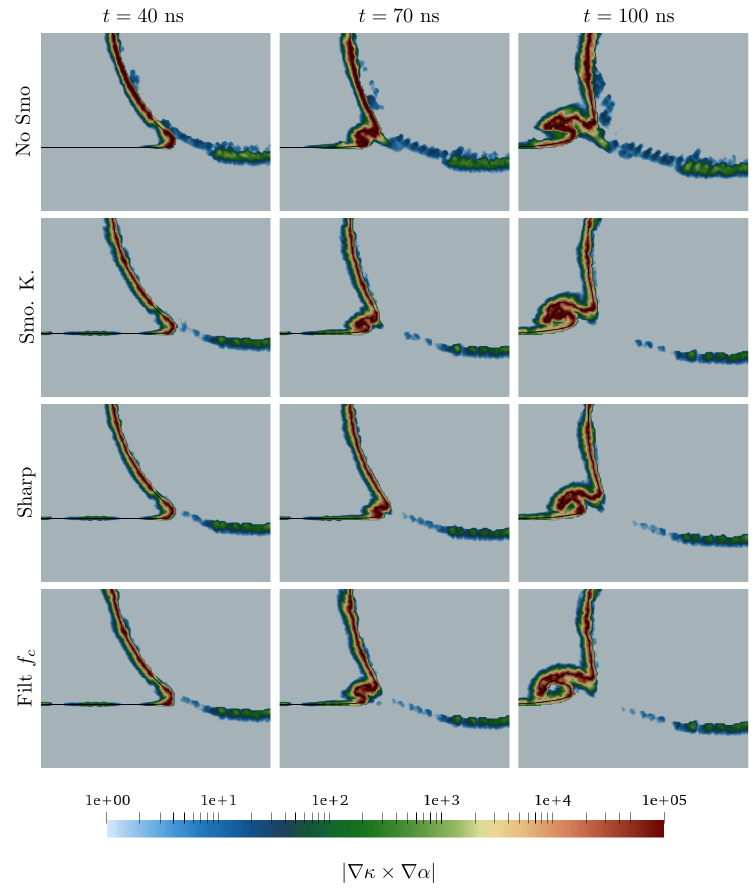
Figure 11. Contour plot of κ α at different instants, with the formation of the prompt jet from |∇ × ∇ | the droplet impact. Figure 12 zooms on the lamella ejection at t = 100 ns, where the velocity vectors are coloured by their magnitude and the black iso-line represents α = 0.5. When the interface treatment is introduced, the ligament ejected points toward the film. Filtering the capillary forces shows a longer ligament than the previous